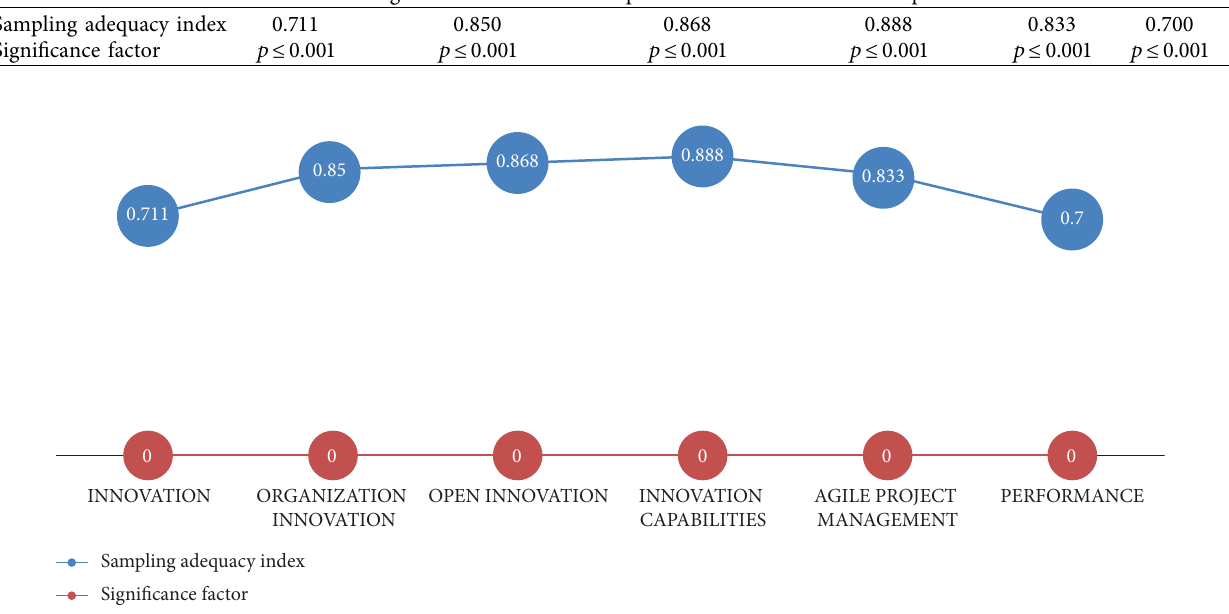
Figure 3: Reliability statistics of the research variables (made by researchers). Table 5: Statistics of the adequacy of general model data (made by